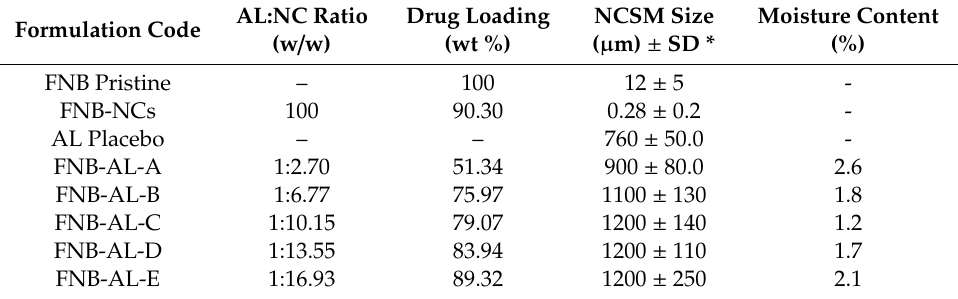
Table 1. Specifications of starting materials and NCSM formulation